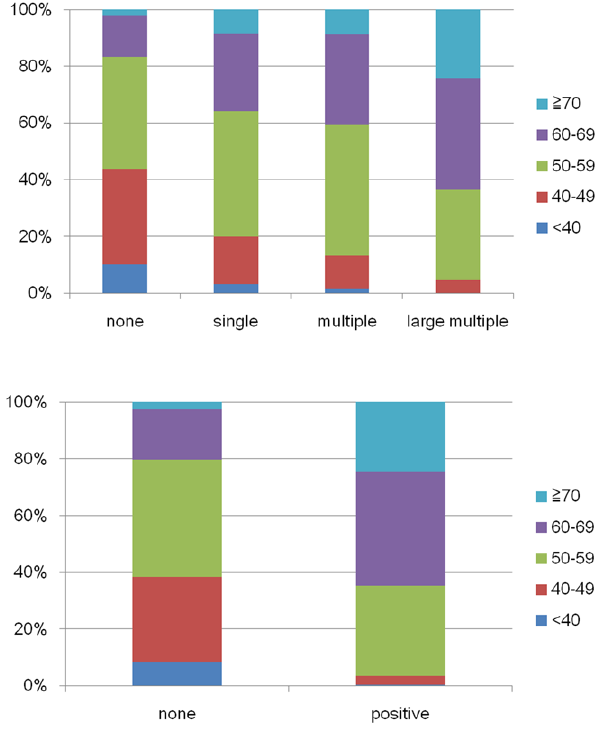
Figure 2. Percentage distribution of leukoaraiosis according to age. Upper panel) Percentage distribution of the various types of subcortical leukoaraiosis according to age. Lower panel) Percentage distribution of the various types of periventricular leukoaraiosis according to age.